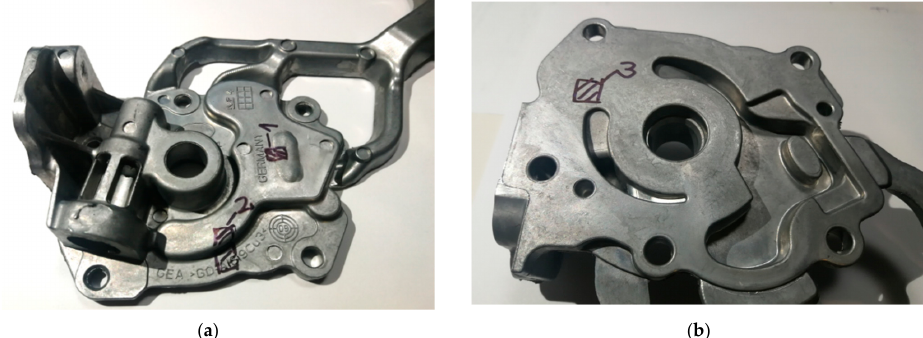
Figure 3. Sampling locations for metallographic tests and microstructure analysis: view from the side of the movable die ( a ); view from the side of the stationary die ( b ).